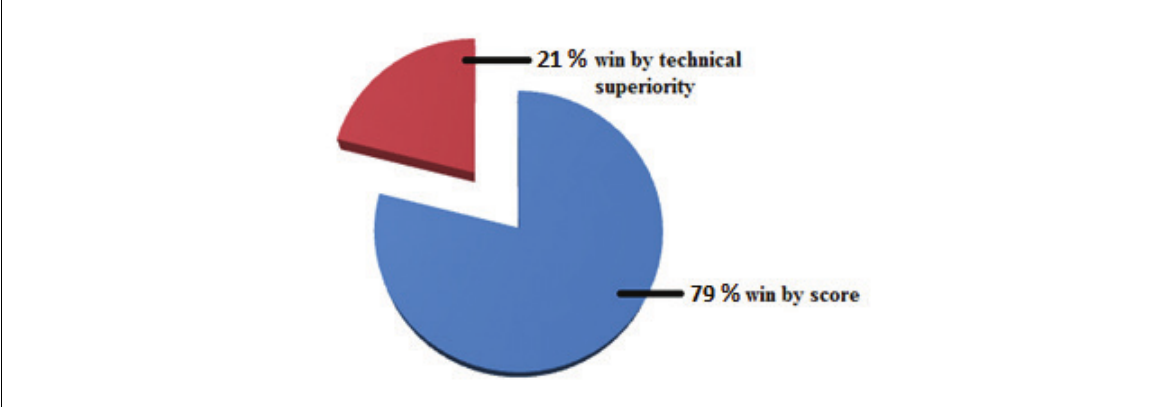
Figure 2. The percentage distribution of lightweight wrestlers’ winning